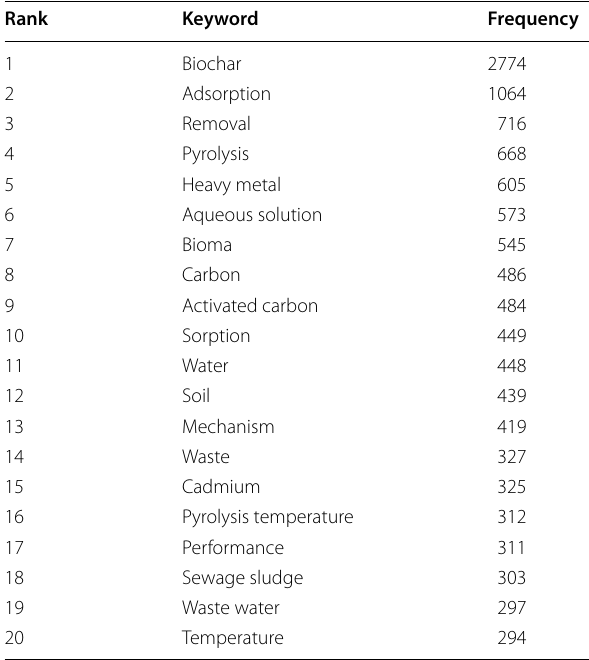
Table 1 The top 20 keywords related to biochar research in